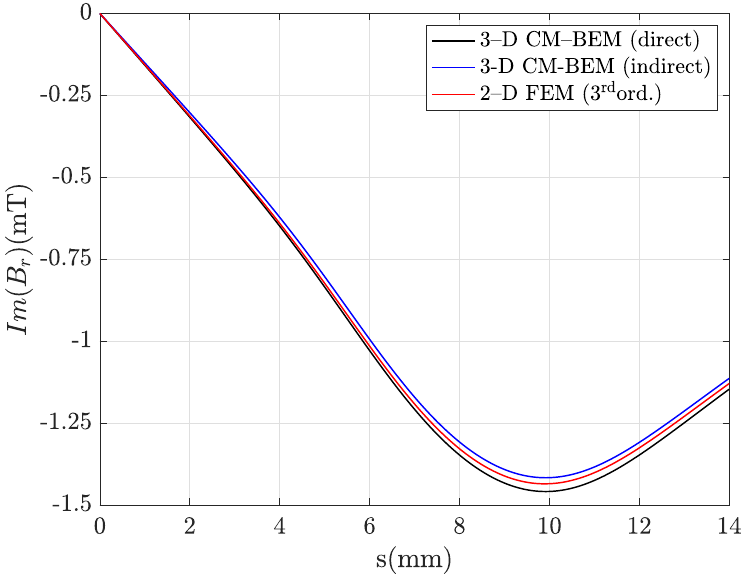
Figure 8. Imaginary part of the radial magnetic flux density component along line C-D (black line: direct formulation, blue line: indirect formulation, red line: 2D FEM, taken as a